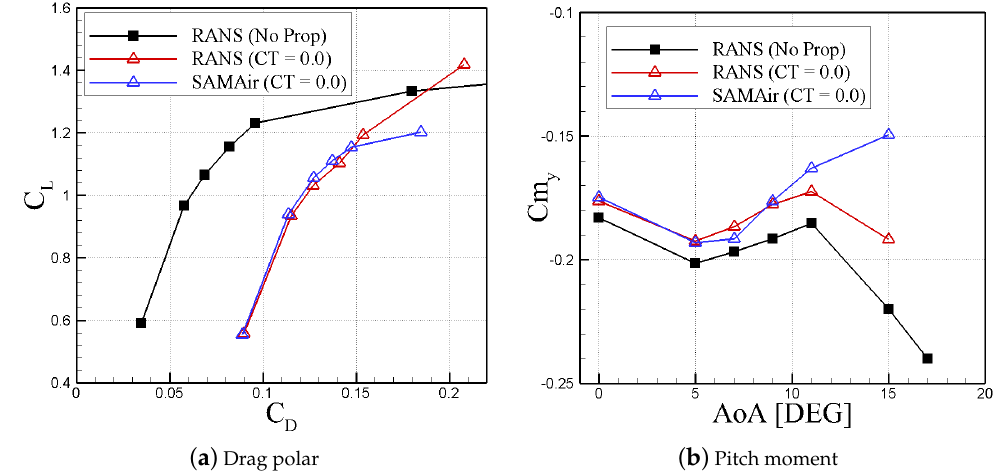
Figure 9. Integrated forces and moments of the propeller-off simulations. Blade forces and moments were included in the shown data.